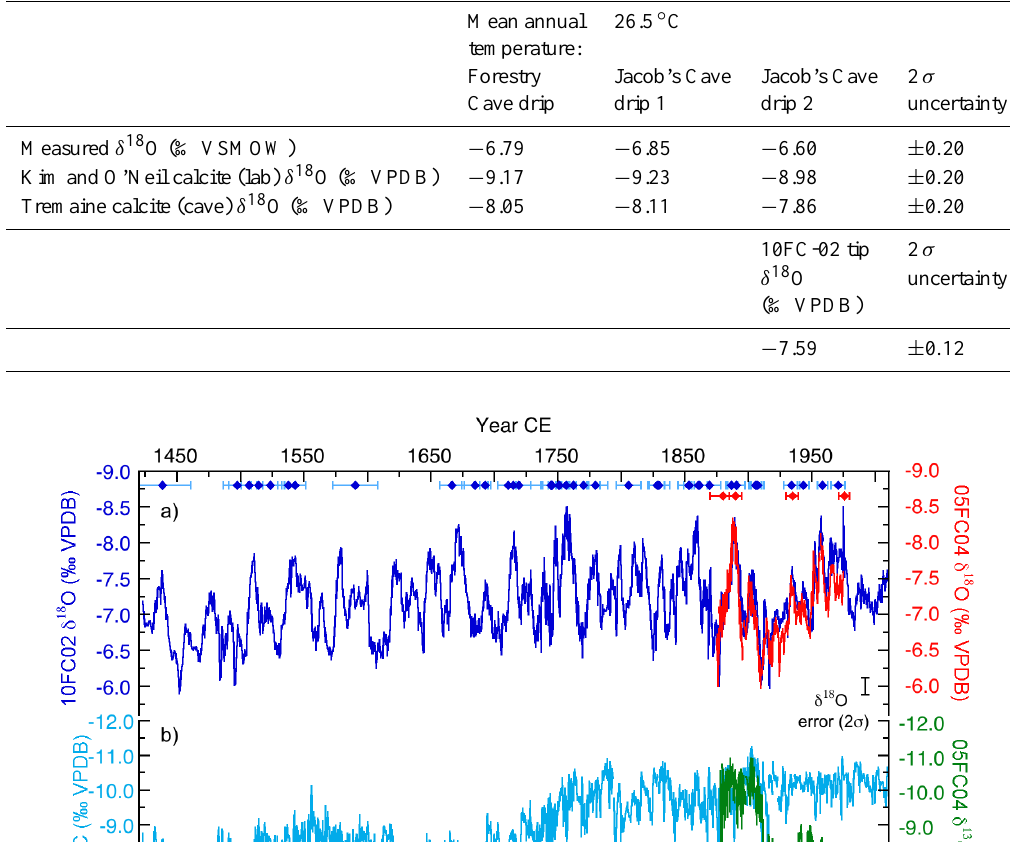
Table 2. Summary of dripwater, predicted and actual calcite δ 18 O values. Predicted values were calculated using drip water δ 18 O values; experimental, laboratory-based as well as cave-based, empirical dripwater–calcite fractionation equations; and mean annual temperature for Honiara from 1952 to 1989 (26.5 ◦ C ± 0.1 ◦ C, 1se) from GISTEMP station data. Forestry Cave and Jacob’s Cave are ∼ 200m apart on the northern slope of Mount Austen. The tip δ 18 O value is the measured value for the top 500µm of the 10FC-02 stalagmite and represents an average value for the preceding ∼ 4 months. Predicted and measured values of δ 18 O calcite fall within error of each other using the cave-based equation, even when only accounting for analytical uncertainty.